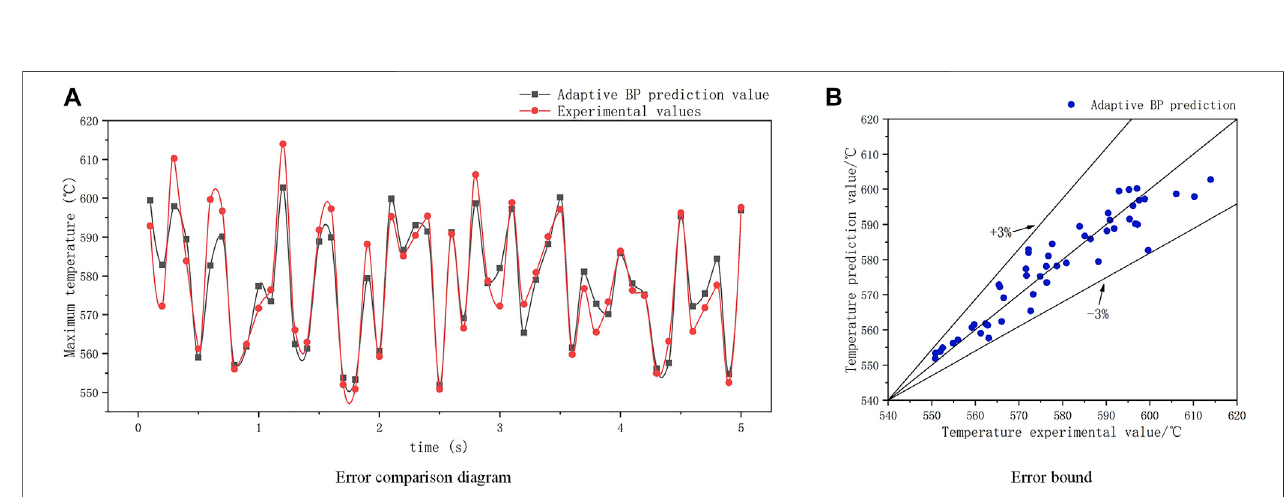
FIGURE 7 | Variation of coolant mass fl ow and cladding maximum temperature within 80s.